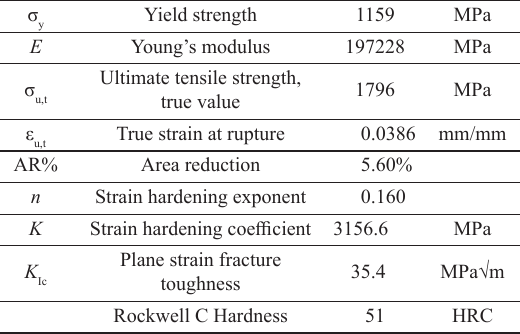
Figure 6. Microstructure of AISI 420 etched with Vilella’s reagent. Table 4. Mechanical properties of the tested AISI